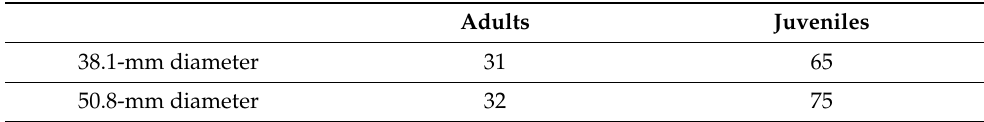
Table 3. Number of adult and juvenile green tree frogs captured in small versus large (diameter) PVC pipes.